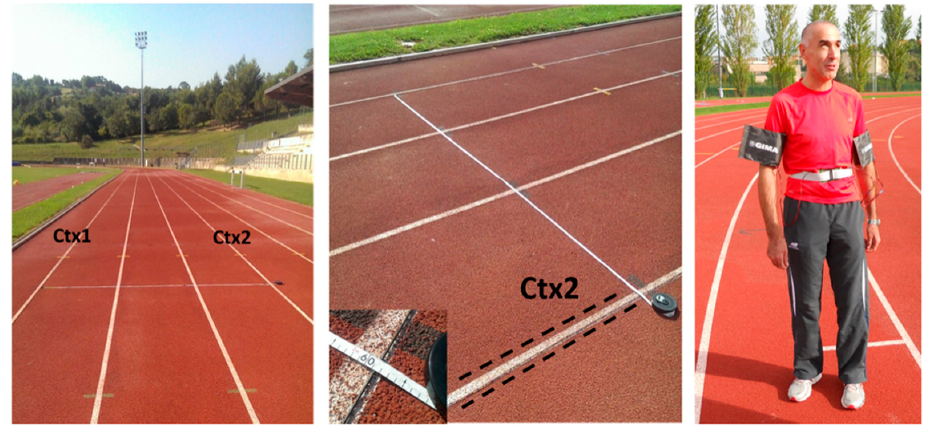
Figure 6. The blind athlete equipped with the electromagnetic sensor at an outdoor running track. Ctx1 and Ctx2 indicate the two wires generating the magnetic field. Table 4. Results of fast walking and running tests, performed by a blind athlete on a running track. Length (m) Time Mean Velocity (m/s) No. Times out of Safe Zone Fast walking